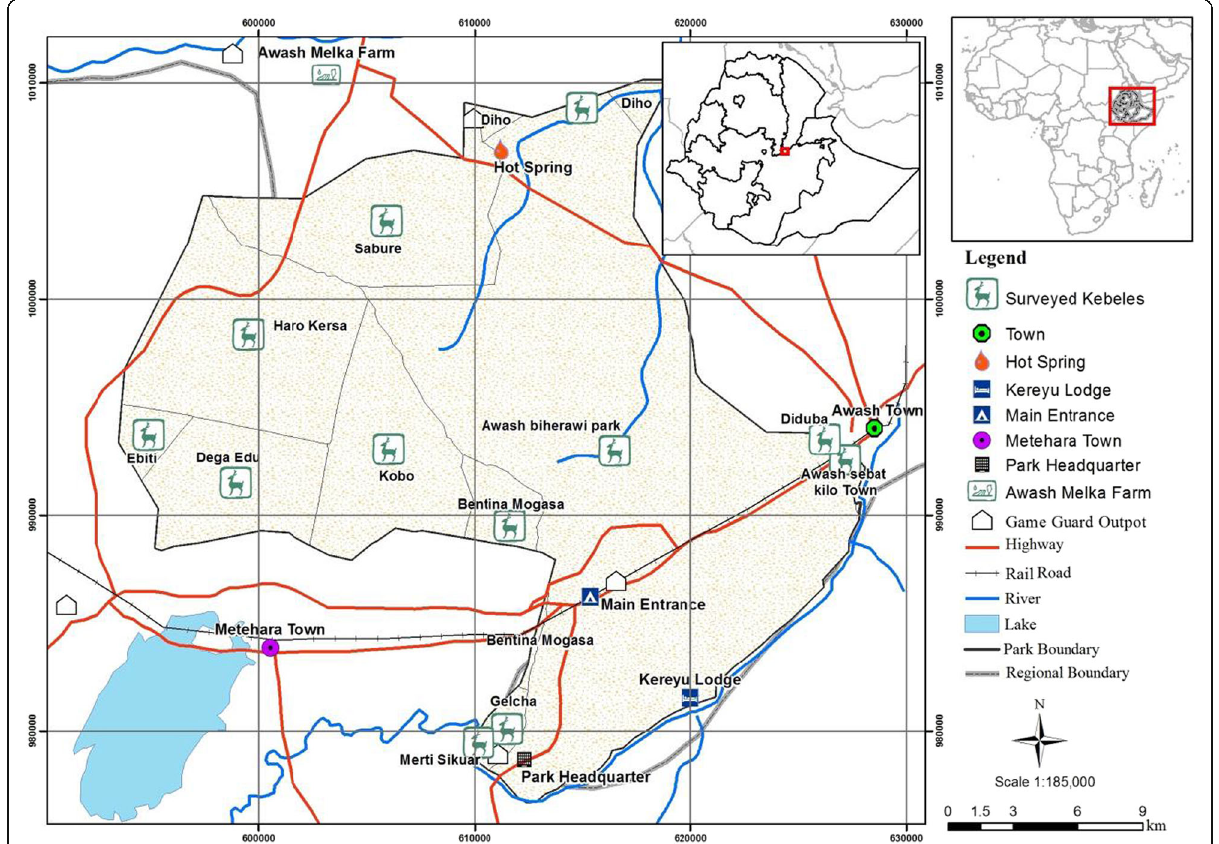
Fig. 1 Map showing distribution of studied localities ( kebeles ) around Awash National Park,